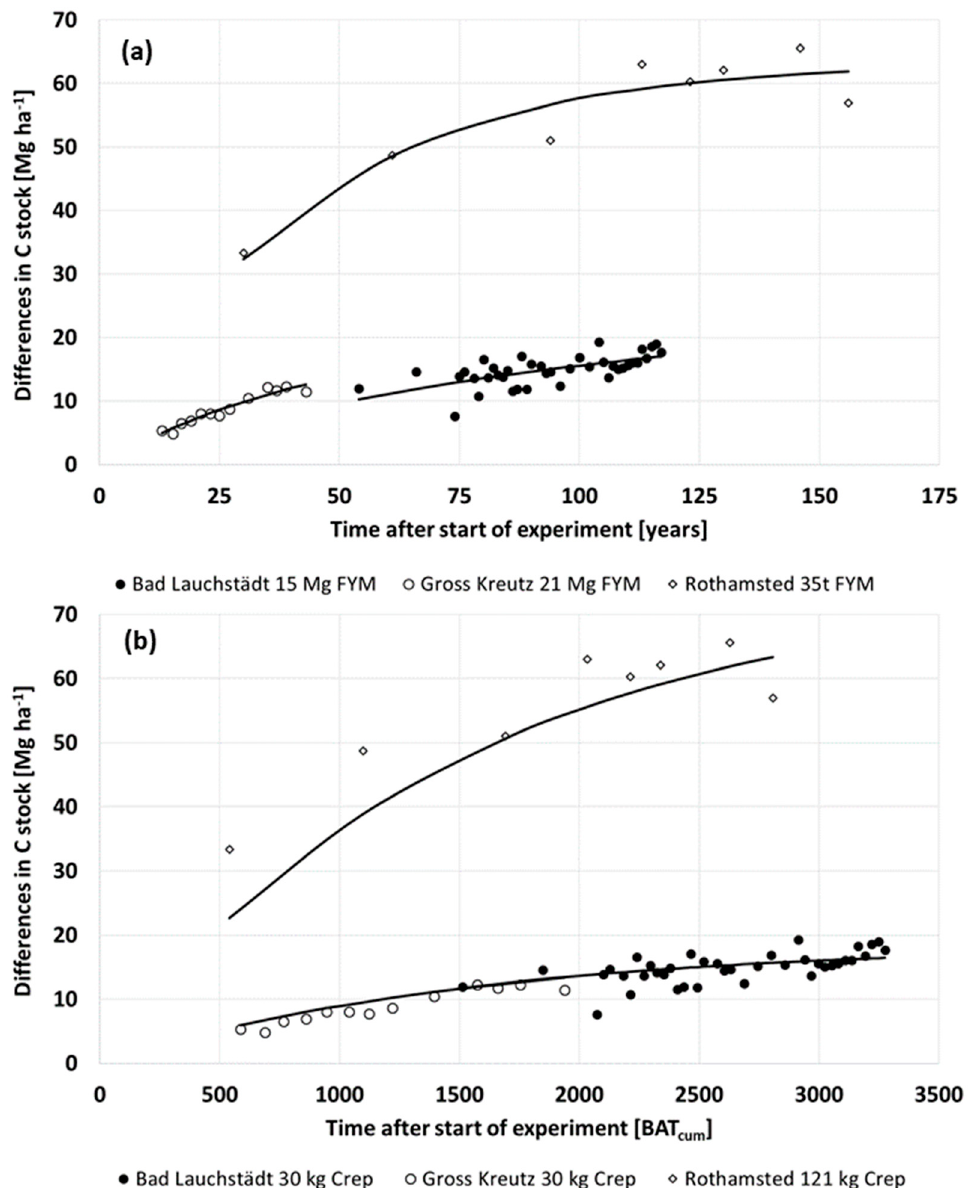
Figure 1. Time course of SOC stock differences between treatments with and without FYM application at three different LTFEs: ( a ) with a conventional timeline in years and ( b ) a BAT–based timeline.